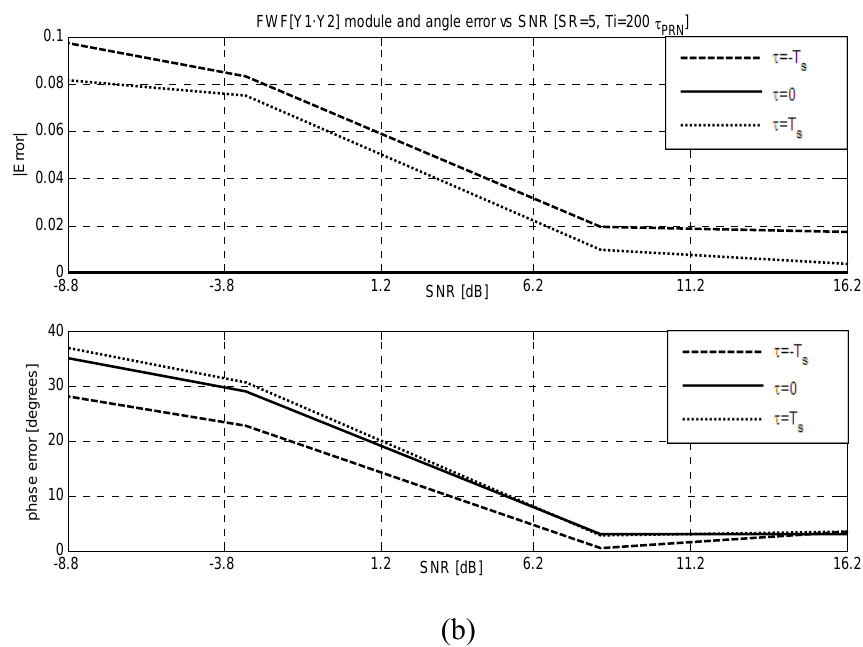
Figure 7. a) FWF estimated by cross-correlating receivers’ output with local replica of PRN sequence FWF (local) (Equations 3-7) for different number of quantization bits and comparison with reference FWF computed with correlated noise with T 3). b) FWF estimated by cross-correlating receivers’ outputs when calibration signal is a PRN sequence FWF (Y1·Y2) (Equations 1-2) for different number of quantization bits and comparison with reference FWF computed with correlated noise with T (Figure